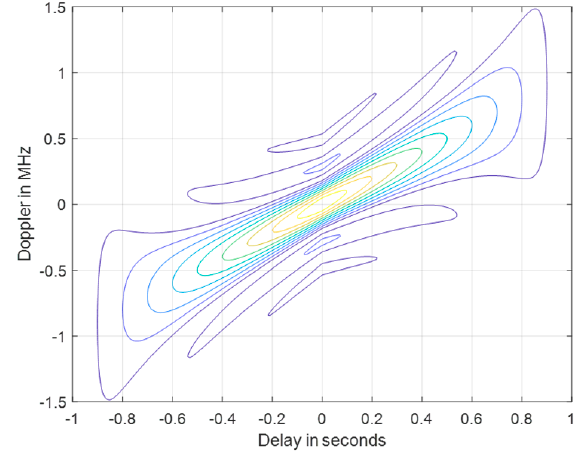
Figure 2. The contour plot of the LFM ambiguity function.